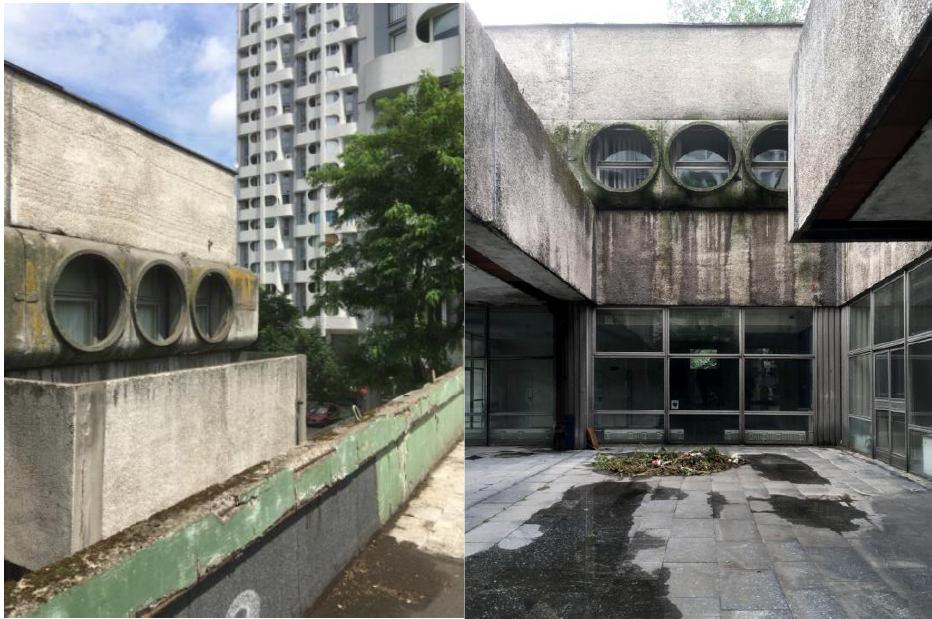
Figure 5. The commercial pavilion by Grunwaldzki Square — the existing condition (photograph by the Authors). Table 3. The thermal modernisation building solutions for the commercial pavilion at Grunwaldzki square [elaborated by the Authors based on 20].